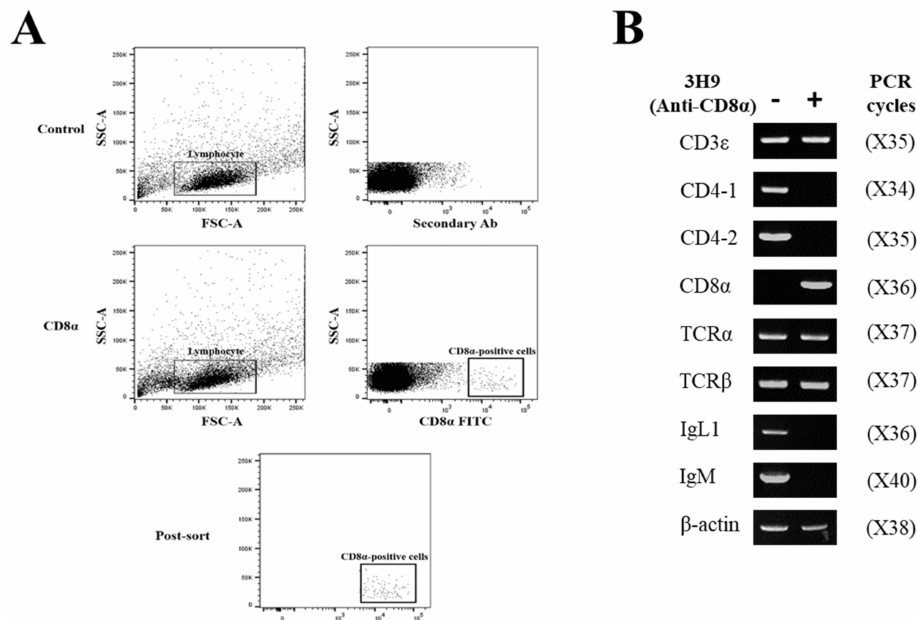
Figure 6. Gene expression profiles of the cell marker genes in flow-sorted spleen and head-kidney lymphocytes. ( A ) Pre- and post-sorting analysis of CD8 α -negative and -positive lymphocytes. ( B ) Specific oligonucleotide primers for T cell and B cell gene expression were employed for RT-PCR and β -actin was used as a housekeeping gene. Numbers in the parenthesis indicated PCR cycles.